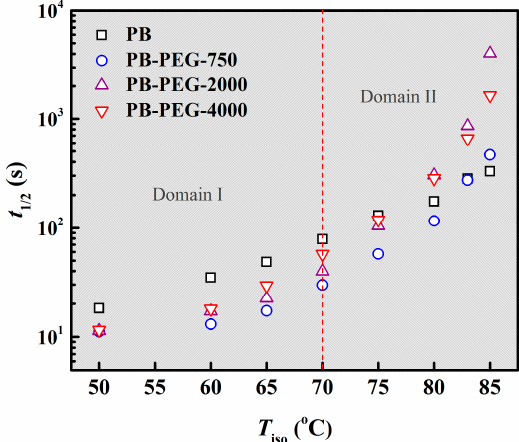
Figure 4. Half-crystallization time ( t 1/2 ) of PB and the PB-PEG copolymers as a function of isothermal crystallization temperatures.